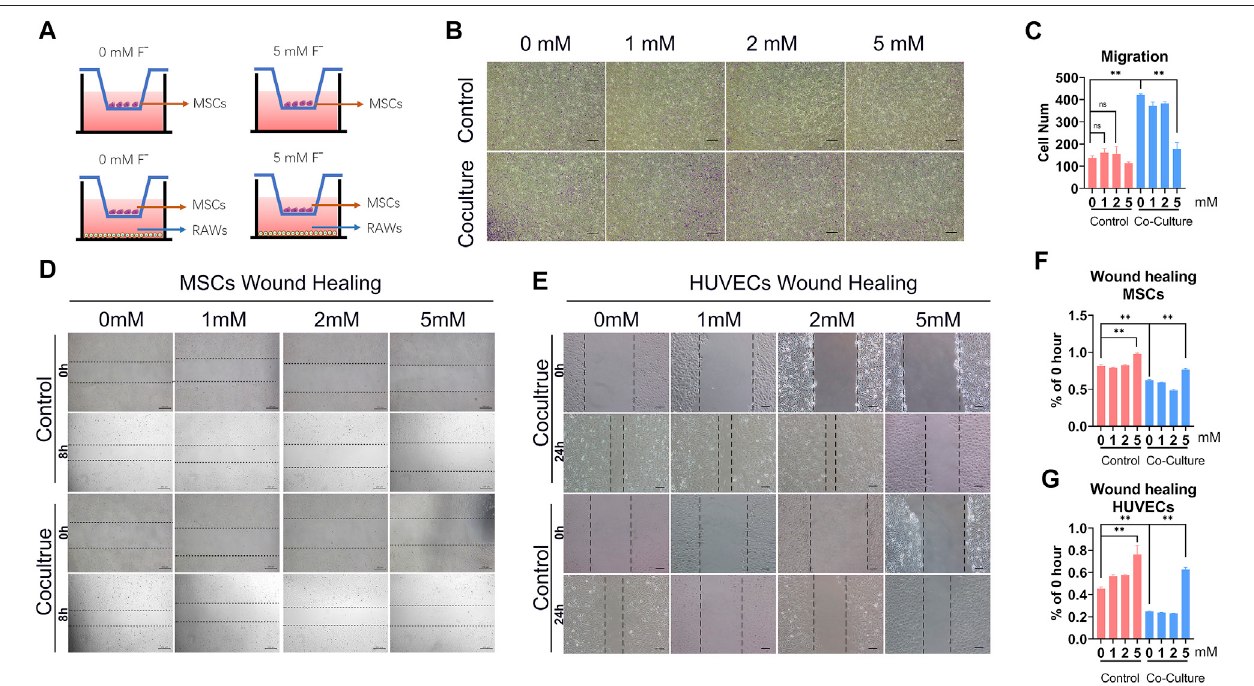
FIGURE 5 | Fluoride-induced macrophages inhibit tube formation and MSCs osteogenic differentiation in vitro . (A) To investigate the effects of tube formation, the Matrigel was coated on plates and the HUVECs were adjusted to 2 × 10 5 cells/mL/well; the supernatant medium of RAW or fl uoride-treated RAW was seeded in wells. The number of tube structures was observed by light microscopy and recorded at 6 h (B) The tube-formation results of the quanti fi ed volume of tube area (ImageJ). (C) ALP activity was measured at 5 days after co-culture using ALP histochemical staining (×100, scale bar = 200 μ m). (D) ALP quanti fi cation activity was detected at OD405 nm. (E) MineralizationandcalciumdepositionatthelateosteogenicdifferentiationwereobservedbythealizarinredSstainingassay(×100,scalebar=200 μ m). (F) Quanti fi cationresultsofalizarinredSstainingshowedthatthemineralizationeffectinco-culturewiththe fl uoride-inducedRAWgroupwaspoor(OD405 nm). (G) RT- qPCR assay determined the osteogenic-related factors, including RUNX2 (g1) and Col1 (g2), after osteogenic differentiation. * p < 0.05, ** p < 0.01, t